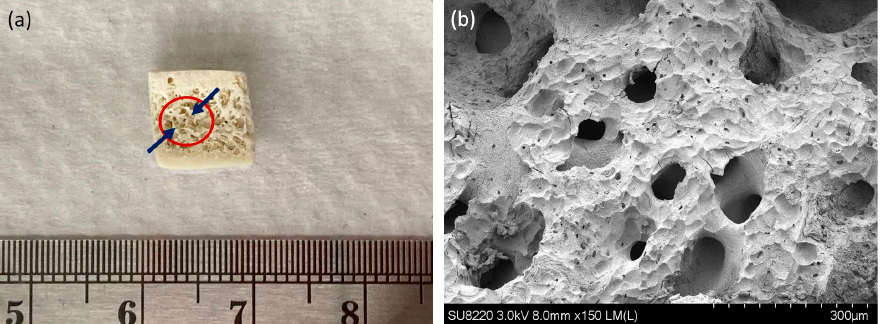
Figure 6. The morphology of procaine mandible bone block ( a ). FE-SEM images of procaine mandible bone block ( b ). Magnification: 150 × .